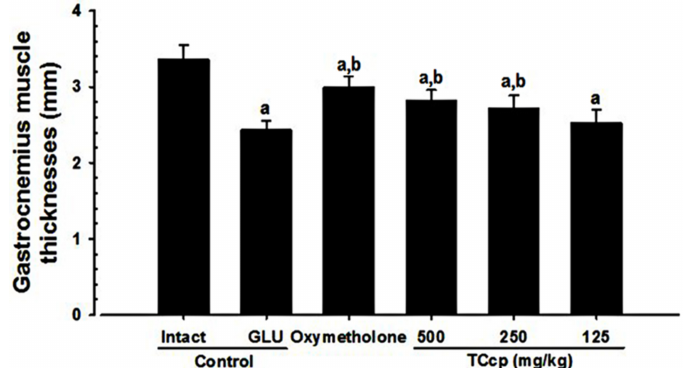
Figure 4. Changes in gastrocnemius muscle thicknesses after muscular exposure in GLU-induced muscular atrophic mice. The thickness of gastrocnemius muscle was measured at day 24 of test material administration using an electronic digital caliper and expressed as mm/mouse lev- els. Values are expressed means ± S.D. of eight mice. TCcp = tart cherry concentrated powder. GLU = glucocorticoid. DEXA = dexamethasone. Oxymetholone (50 mg/kg) dissolved in distilled water was orally administered. a p < 0.01 as compared with intact control by LSD test. b p < 0.01 as compared with GLU control by LSD test.